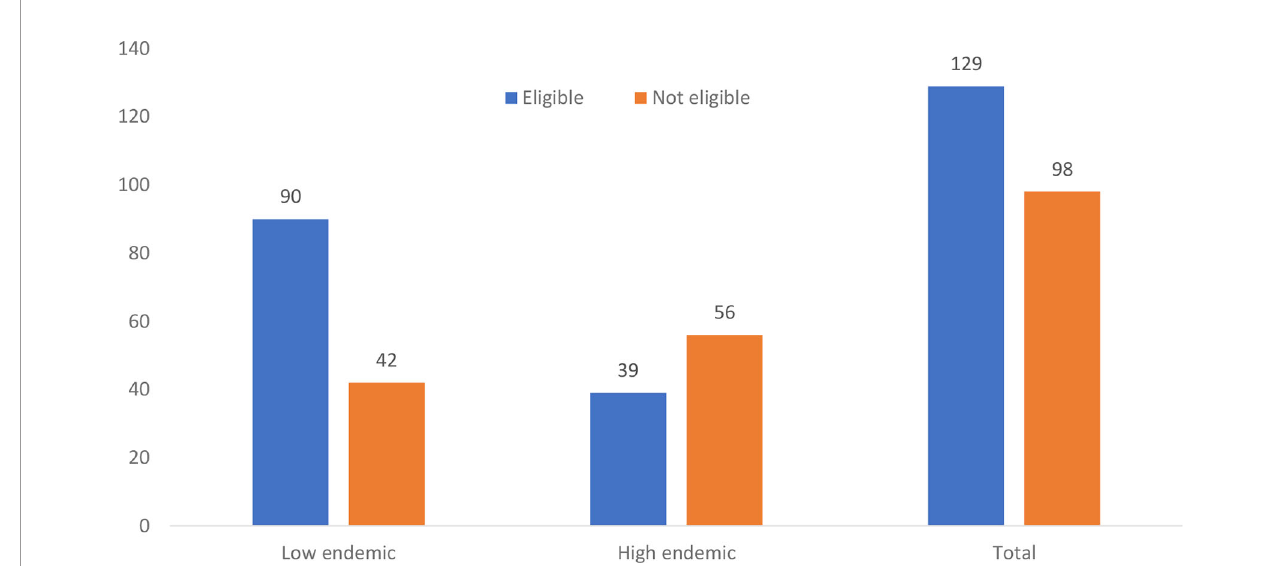
FIGURE 3 | Variation in the treatment eligibility by endemicity using the TREAT-B score of ≥ 2.0.